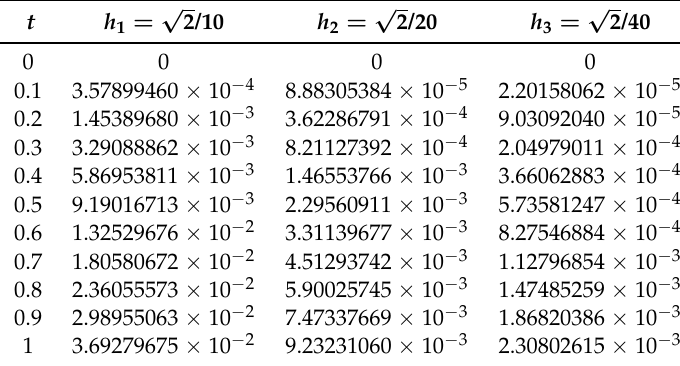
and α = 0.3 for Example 2. 1000